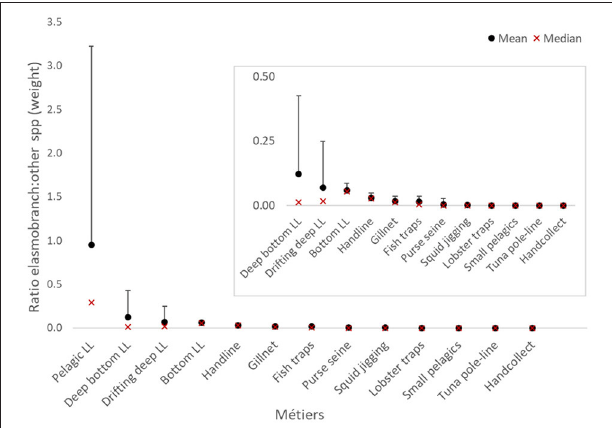
FIGURE 4 | Proportional weight landed of elasmobranchs per unit weight of other species, by fishery métier. INSET, After removing métier pelagic longline.